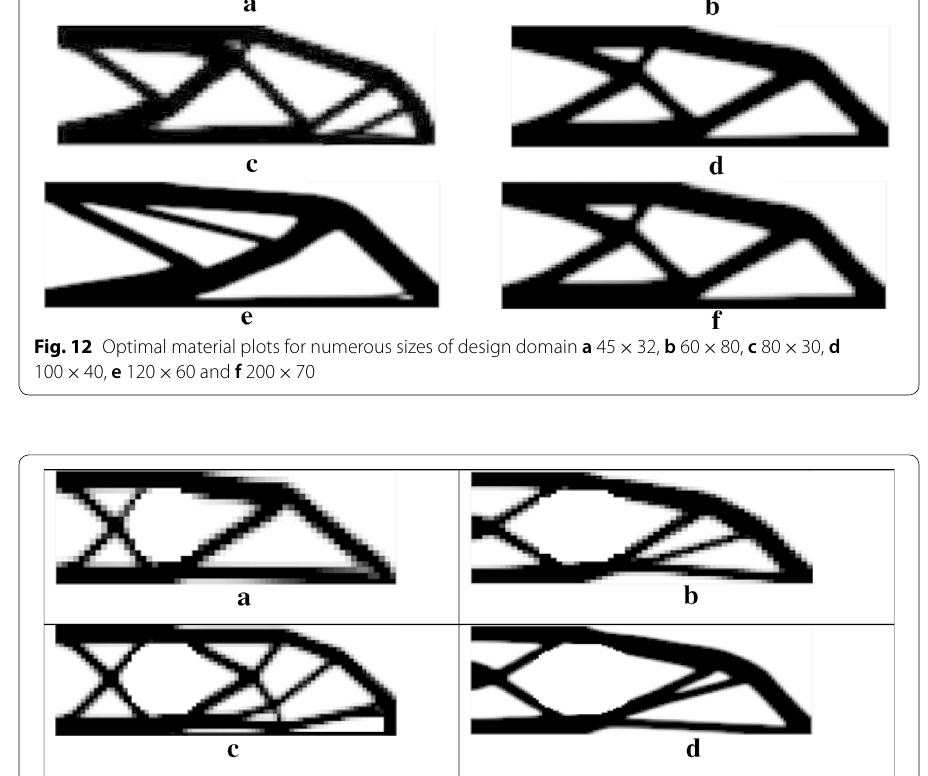
40, b 60 30, c 80 30, and d × × ×